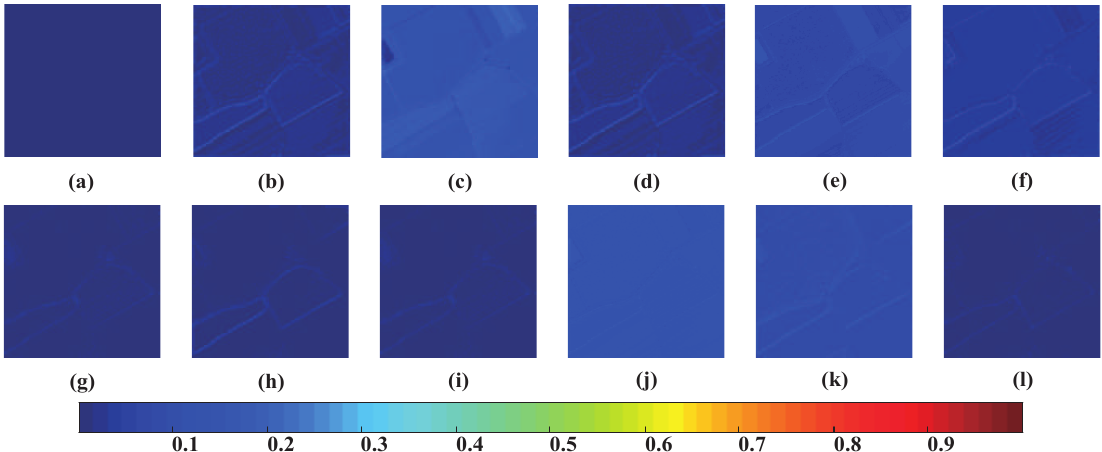
Figure 8. Absolute difference maps between the pansharpened results and the reference one obtained by different methods on the Salinas Scene data set: ( a ) reference, ( b ) SFIM, ( c ) MTF-GLP,